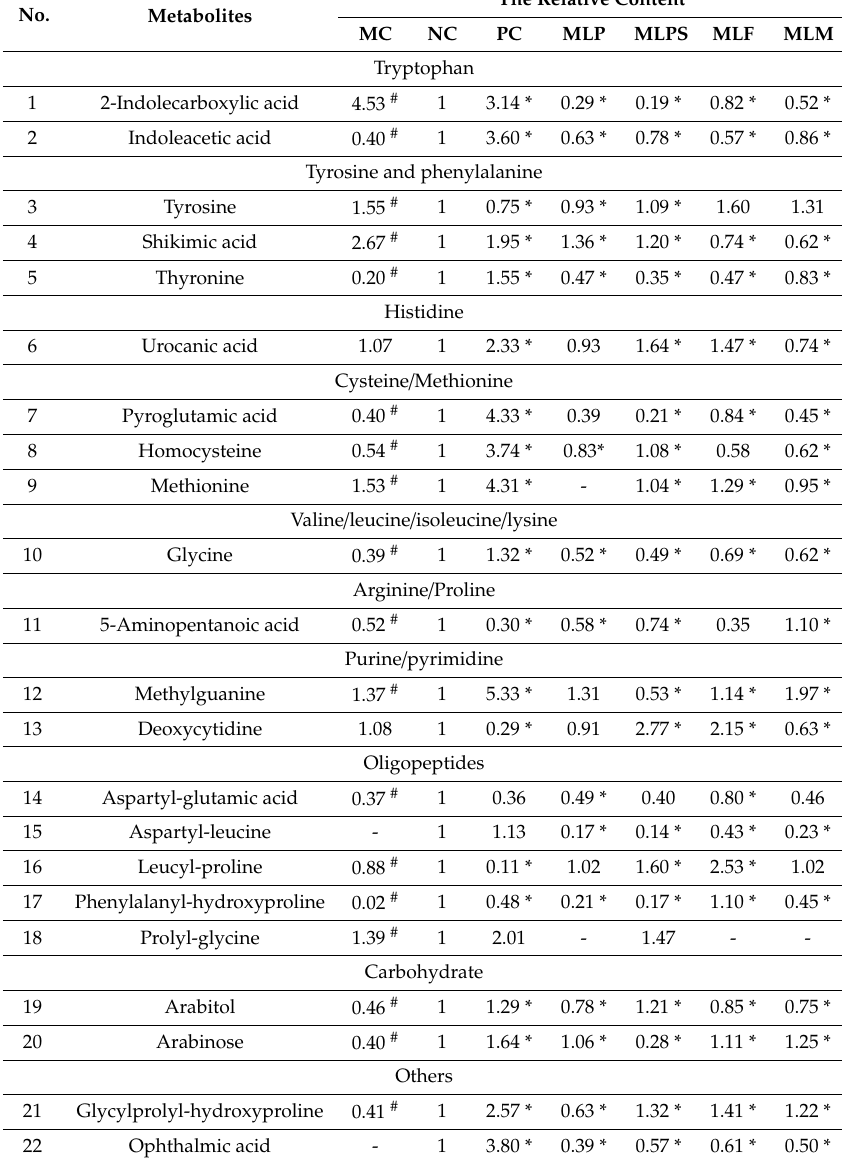
Table 4. Representative and main di ff erentiated urinary metabolites derived from mammalian-gut microbial co-metabolism among di ff erent groups analyzed by UPLC-Triple-TOF-MS and GC-MS.